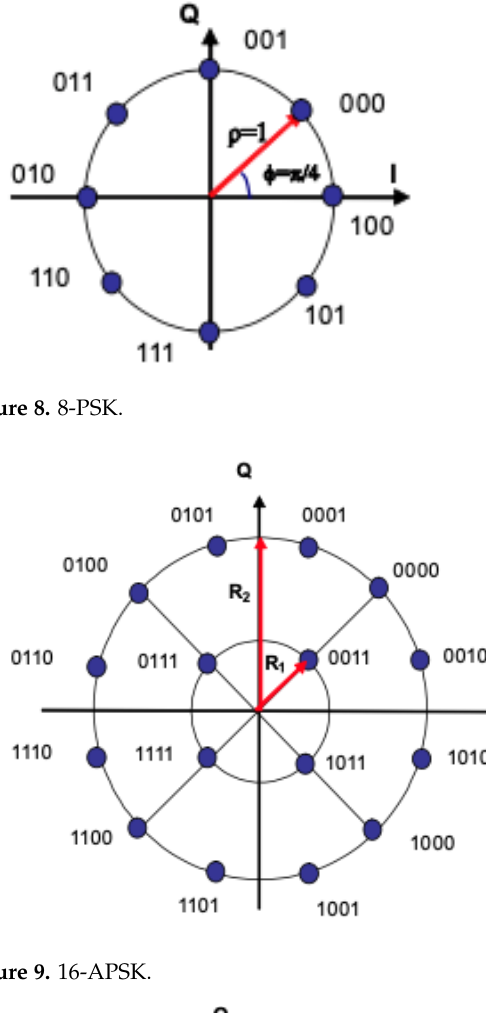
Figure 9. 16-APSK.